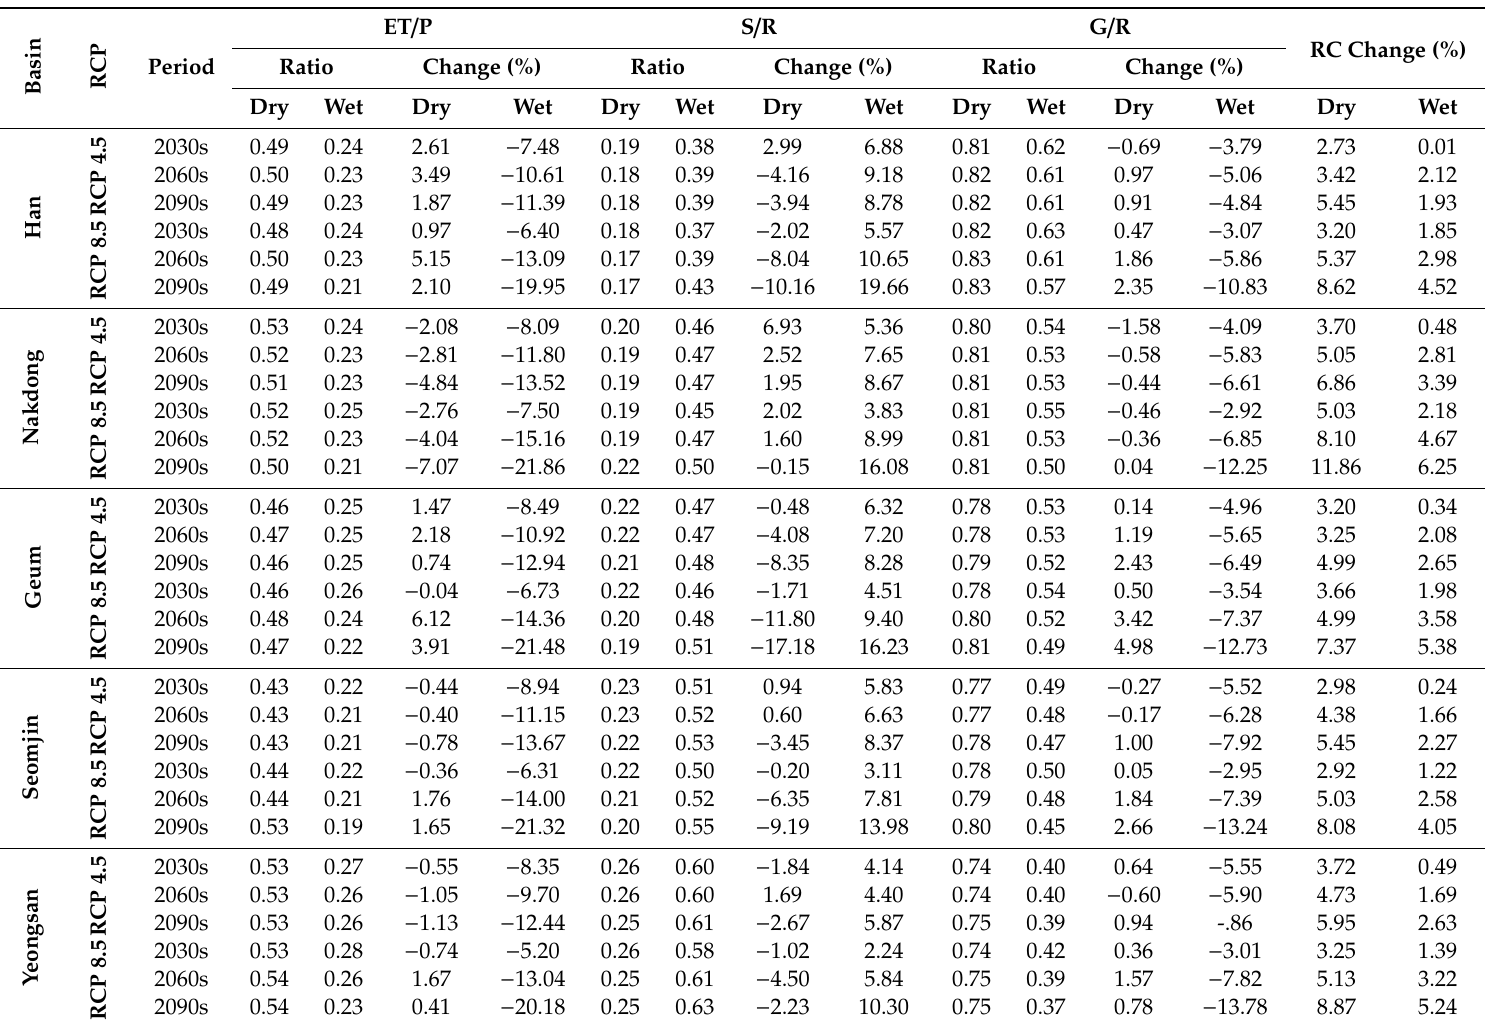
Table 8. Change in the runo ff coe ffi cients corresponding to ET / P, S / R, and G /